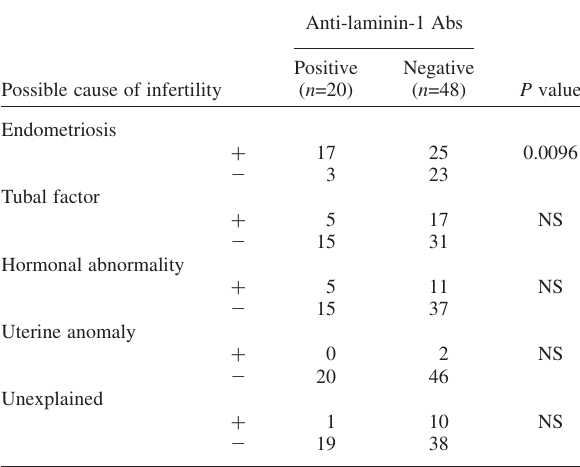
TABLE III Association between IgG anti-laminin-1 autoantibodies and possible causes of infertility in 68 infertile patients who underwent